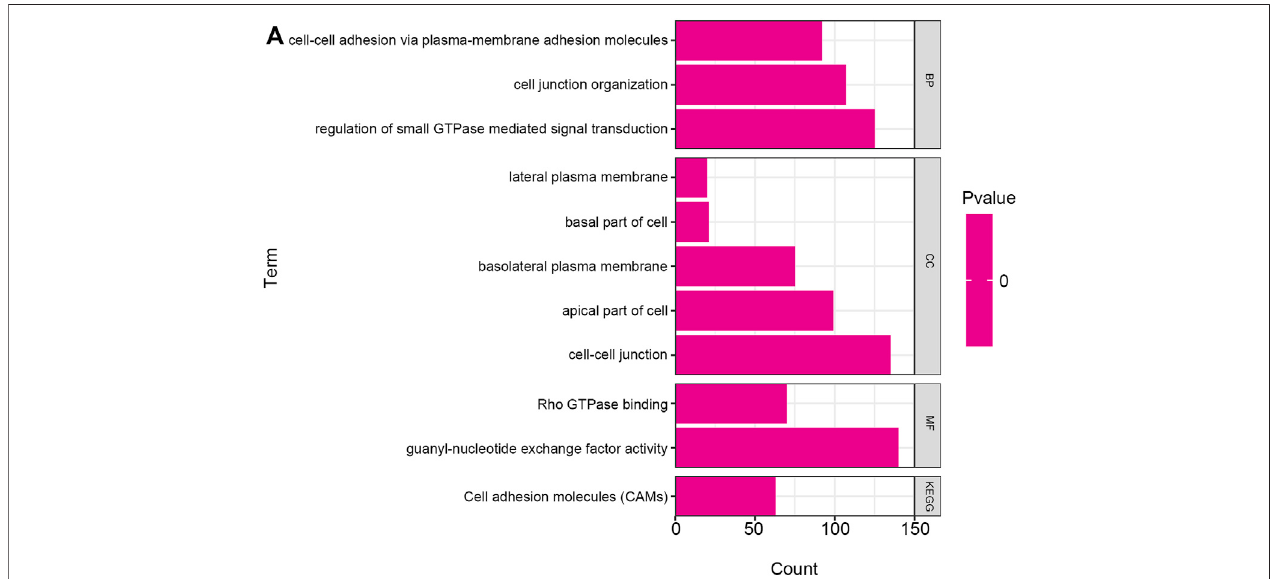
FIGURE 6 | GO annotation and KEGG pathway in lung cancer. The GO annotation and KEGG pathway of RAB11FIP1 co-expressed genes in lung tissue were analyzed by GSEA. (A) Biological processes. Cellular components. Molecular functions. KEGG pathway analysis. FDR from GSEA was 0.